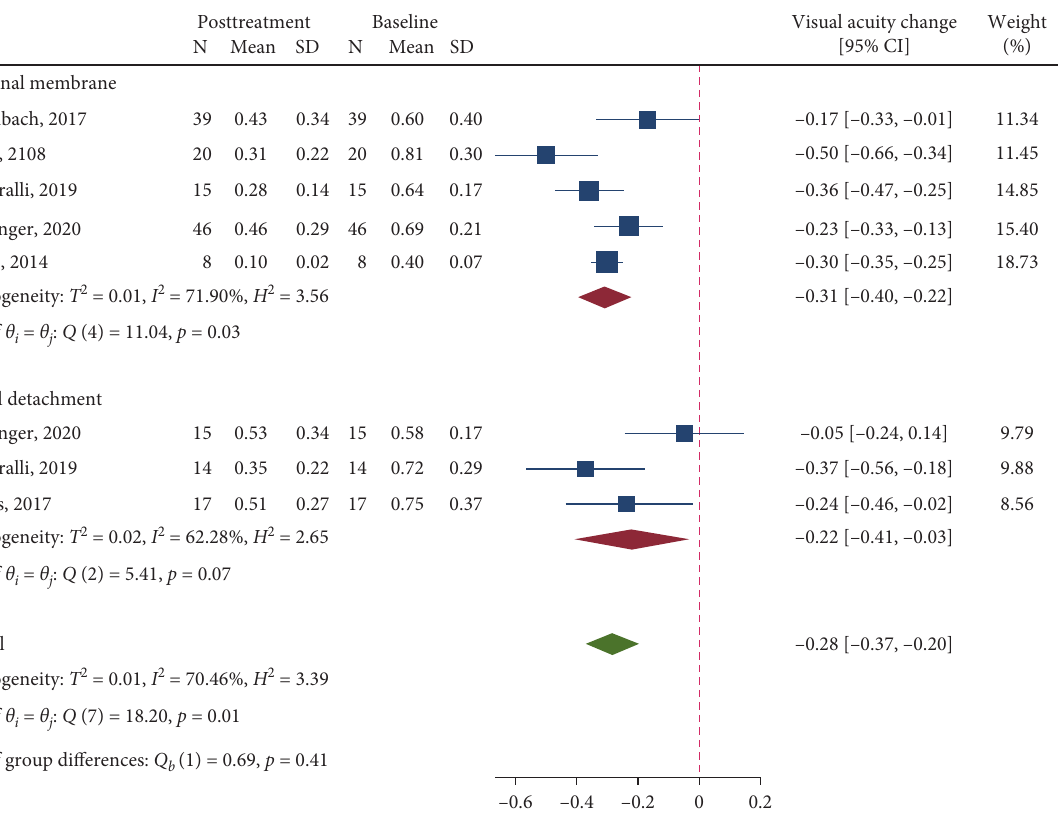
Figure 2: A forest plot showing the mean change in best-corrected visual acuity considering the last available follow-up after treatment with dexamethasone